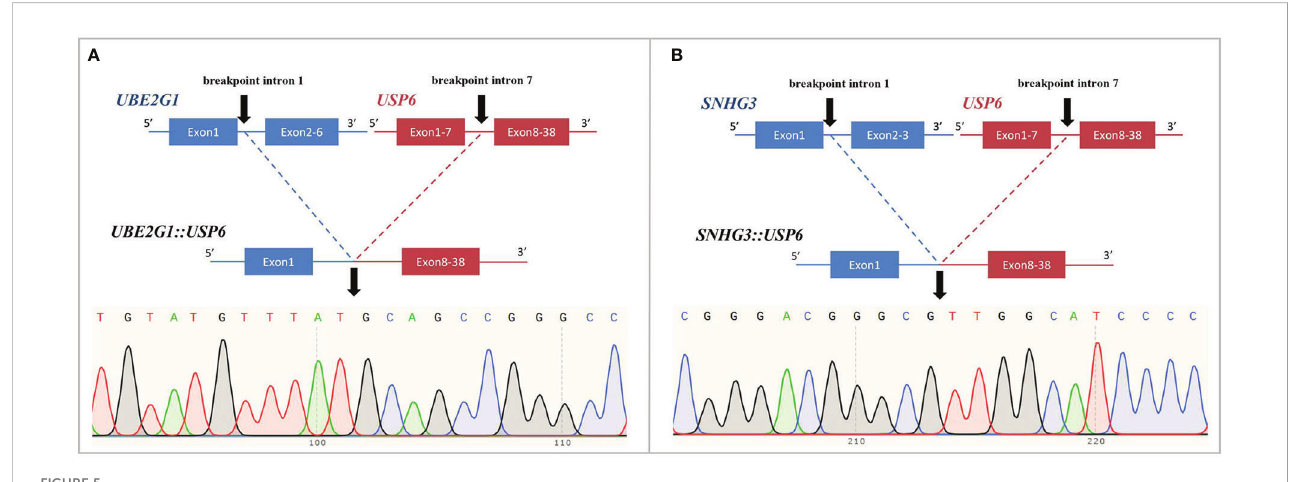
FIGURE 5 Novel fusion partners identi fi ed in USP6 -associated soft tissue tumors with bone metaplasia. (A) NGS-based technology showing detection of UBE2G1 (exon1) :: USP6 (exon8-38) fusion and breakpoint information between the two genes. Sanger sequencing analysis con fi rmed the presence of UBE2G1::